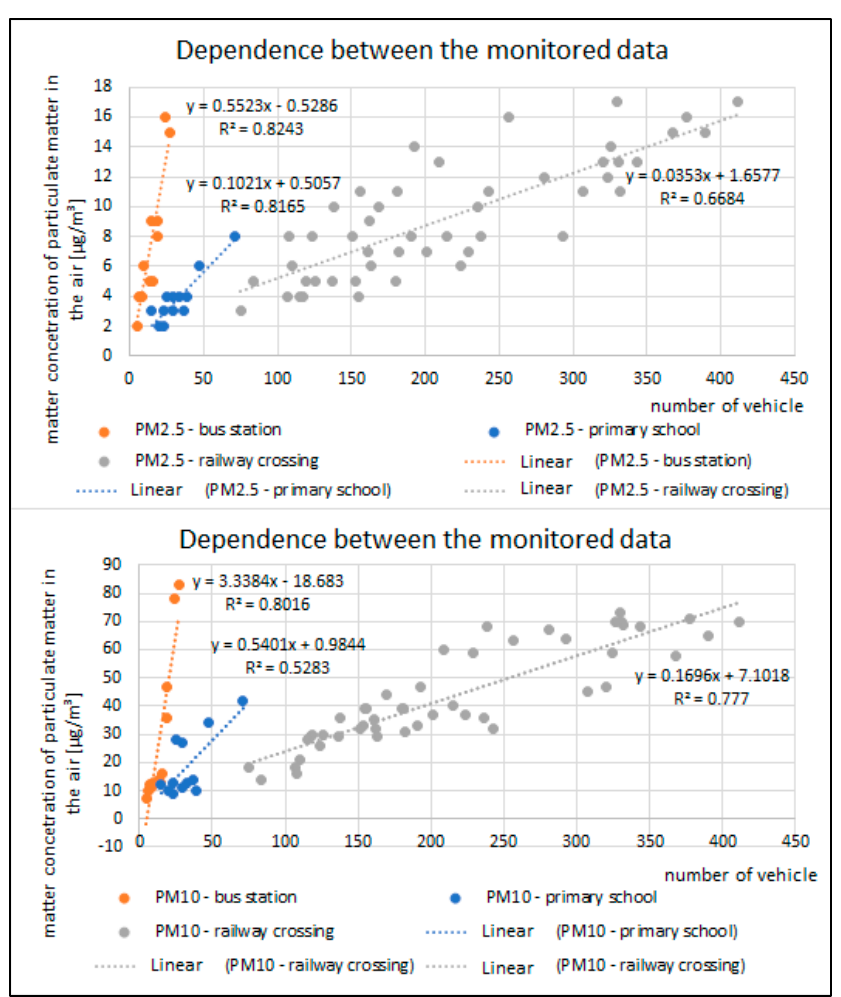
Figure 7. Relationship between the number of vehicles and concentration of particulate emissions. Table 6. Evaluation of monitored data